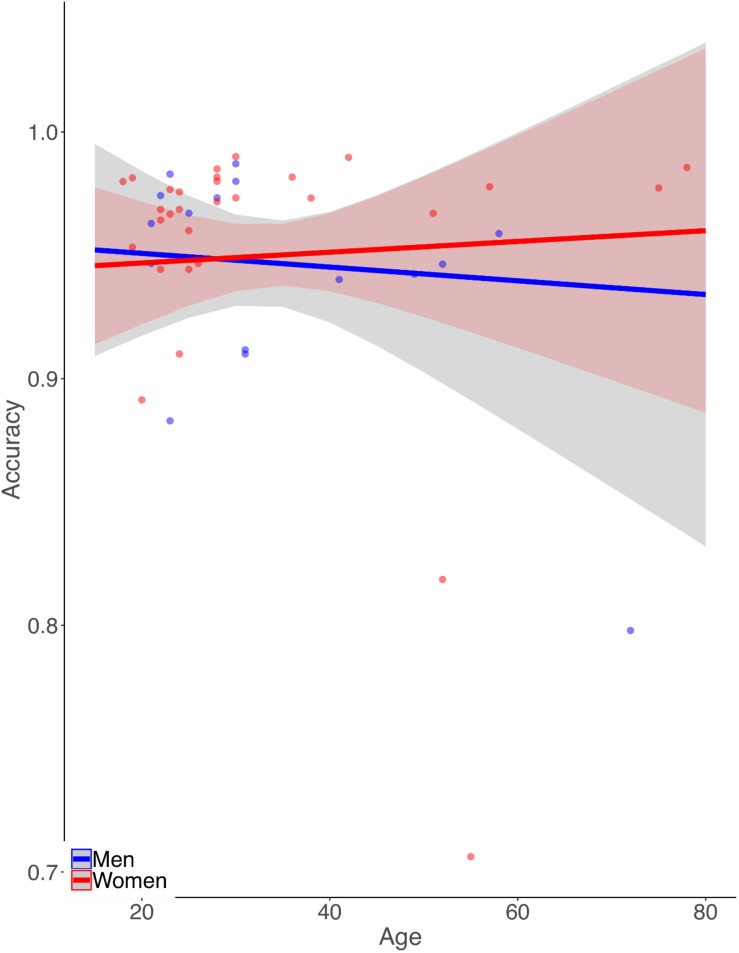
Illustration of the pattern of results from the rank-based multiple linear regression analysis of reading aloud accuracy. Dots represent mean accuracies for individual participants. Accuracy declines more with age for men than for women.